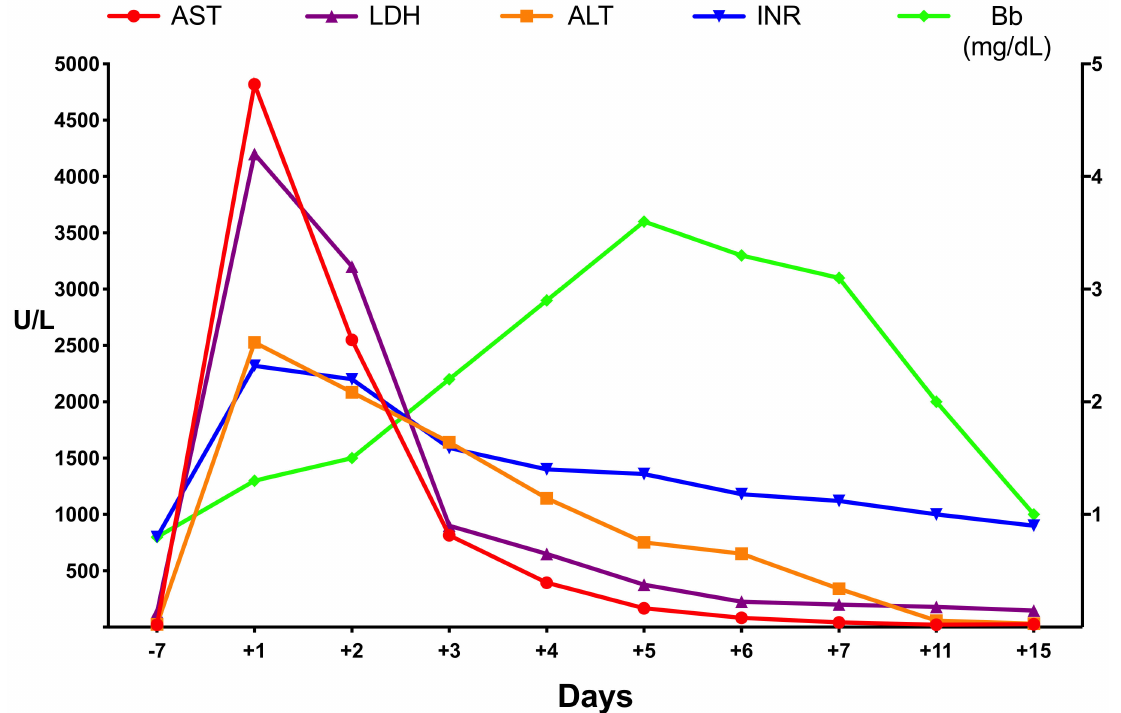
Figure 1. Laboratory parameters during the course of acute cardiogenic liver injury (ACLI) in a patient with respiratory failure due to drug overdose. Abbreviations: AST: aspartate aminotransferase; ALT: alanine aminotransferase; LDH: lactate dehydrogenase; Bb; bilirubin; INR: international normalized